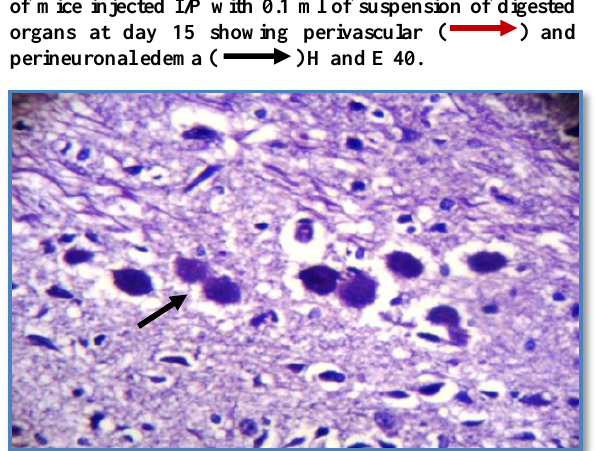
Figure, 2: Histopathological section in the brain (cerebrum) of mice injected I/P with 0.1 ml suspension of digested organs at day 15 showing degenerated neurons characterized by shrunken dark blue stained (basophilic) cell bodie ( ) H and E 40x.